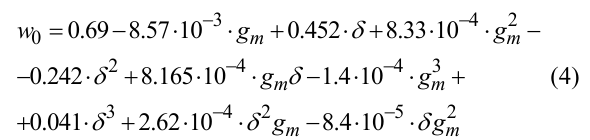
Figure 5. As regarding the KW with respect to SOD, graphical representation on spatial coordonates is not so suitable in the range of MTH between 20-40 mm.